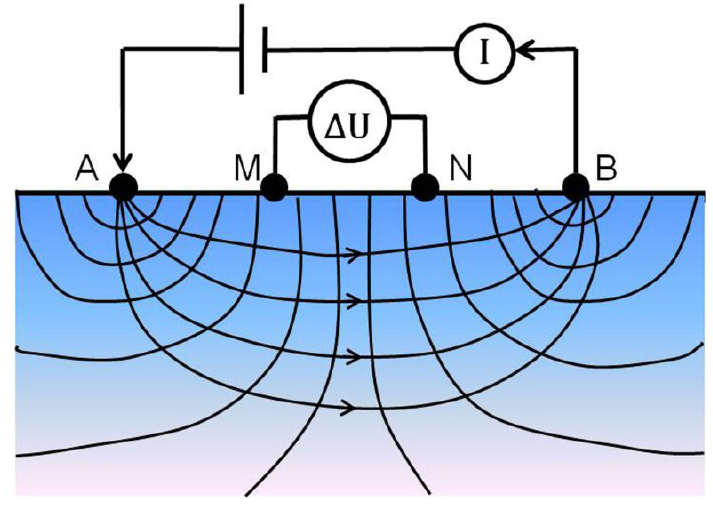
Figure 1. Common four-point surface resistivity